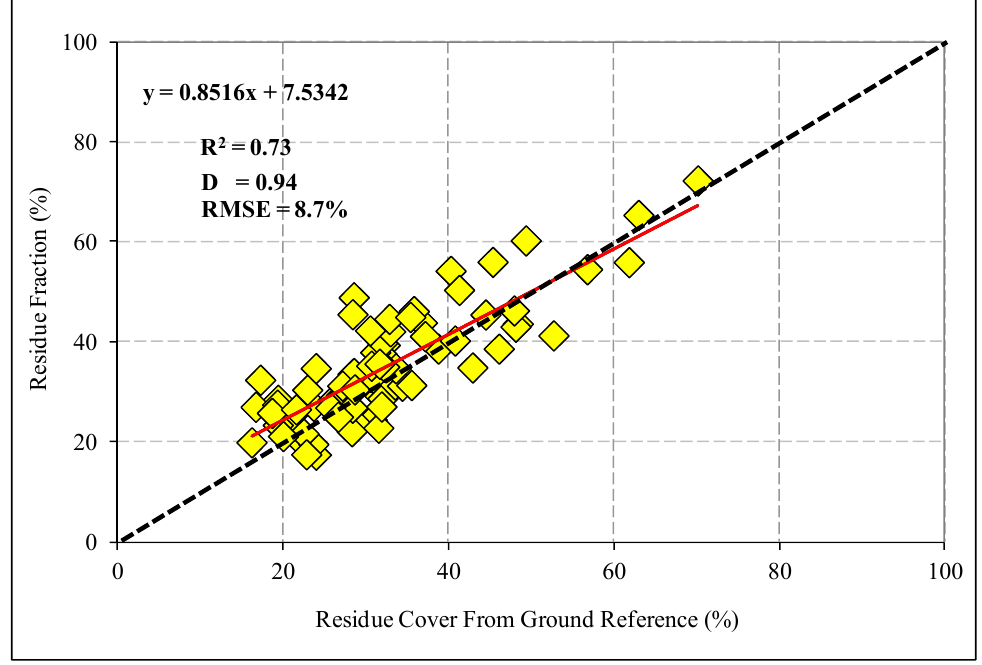
Figure 7. Relationship between percent crop residue cover (PCRC) derived from Hyperion data and the ground-reference measurements (PCRC G ). The black line represents the 1:1 line and the red one indicates the regression